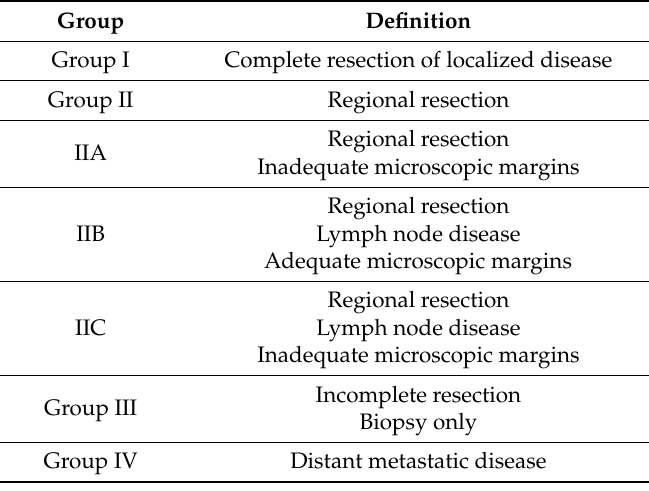
Table 2. Clinical Group for